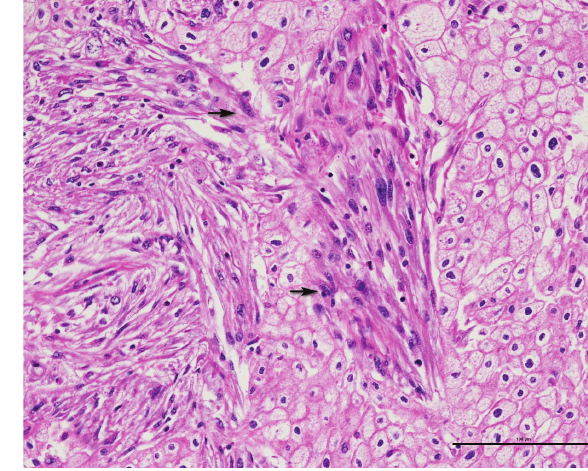
Figure 2: Nuclear crowding (black arrow) with pleomorphism (white arrow, three-fold variation in nuclear size and distinct nuclear chro- matin irregularities) (400x), CTG 2, FNG 3